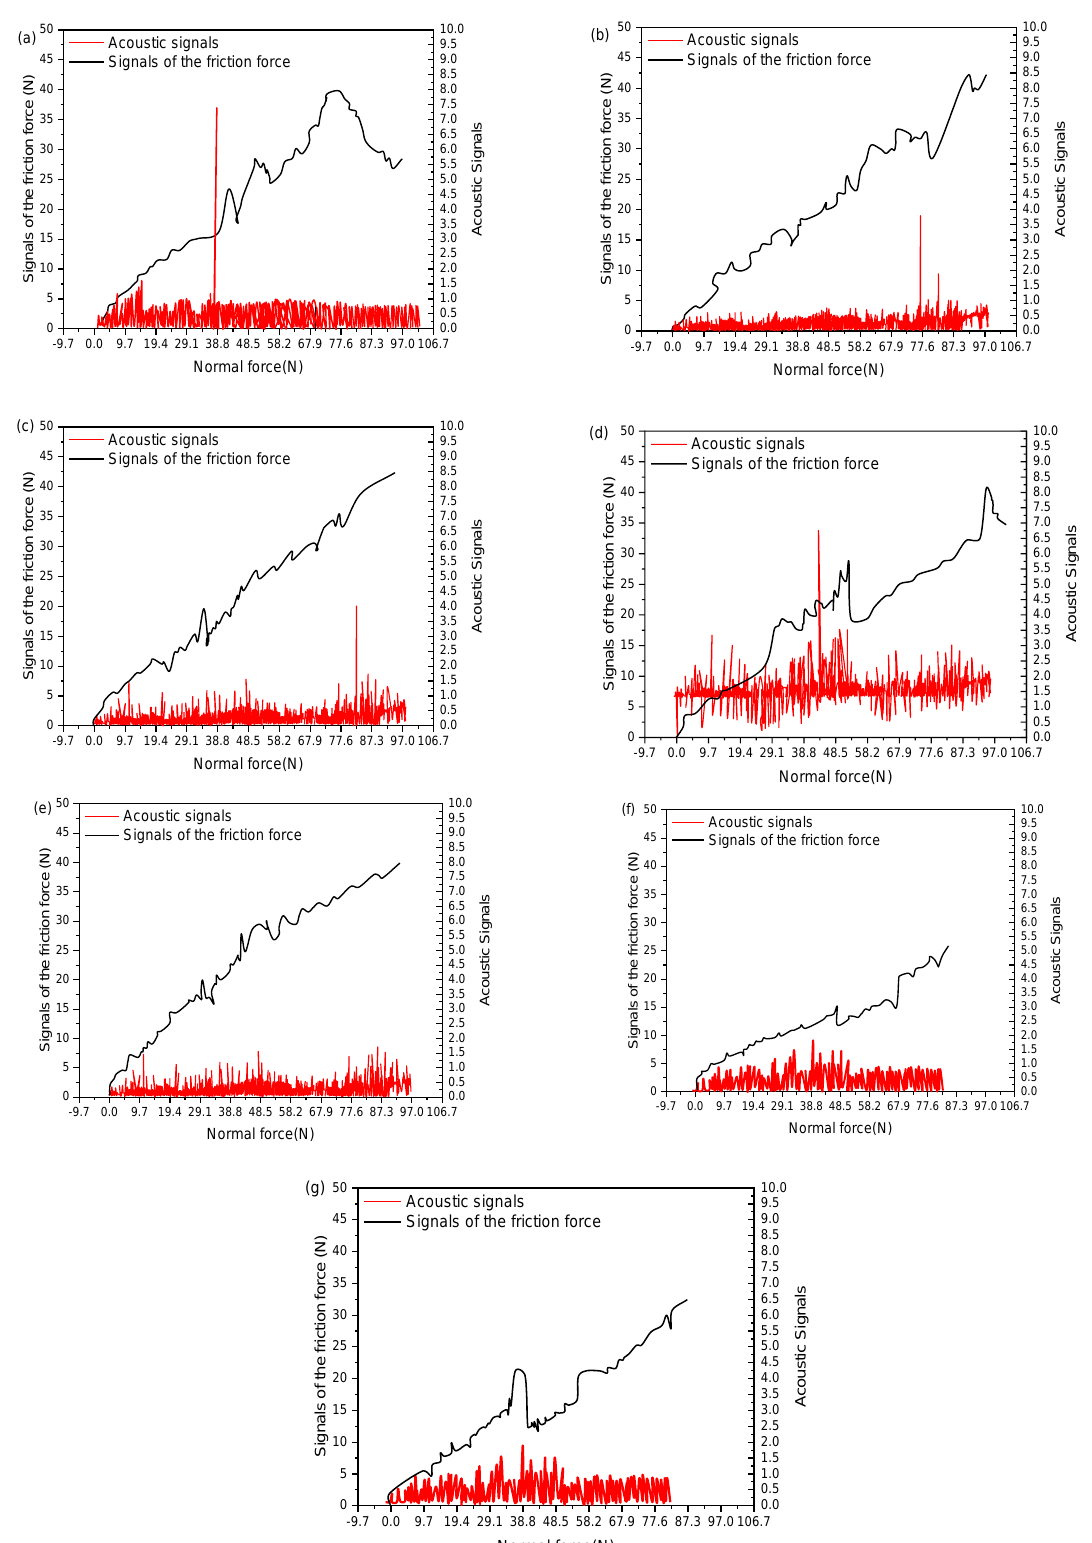
Figure 4. Acoustic and friction indications of various coatings of B 4 C/Ni63; ( a ) 10% B 4 C, ( b ) 15% B 4 C, ( c ) 20% B 4 C, ( d ) 25% B 4 C, ( e ) 30% B 4 C, ( f ) 35% B 4 C, ( g ) 40% B 4 C.